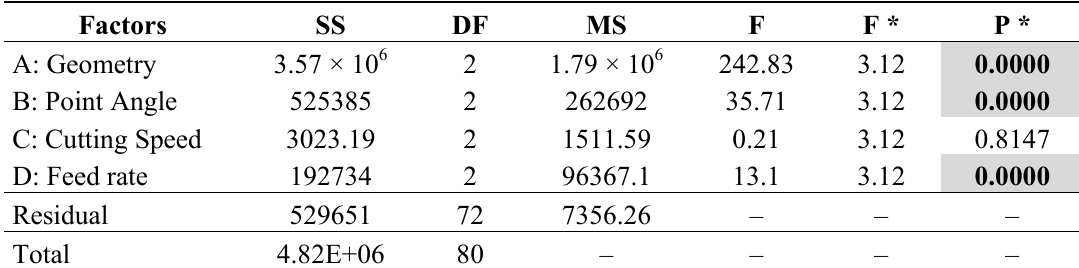
Table 3. ANOVA analysis developed for thrust force.